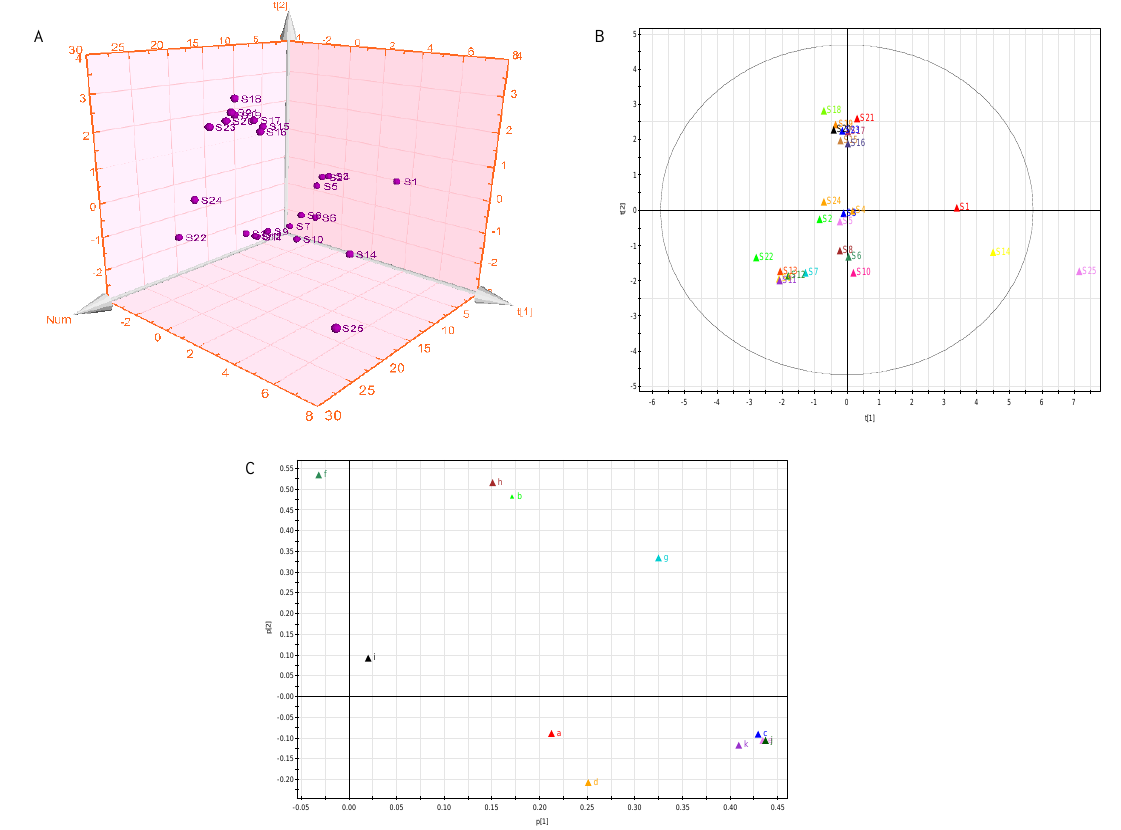
Figure 4. ( A ) The 3D scatter plot of scores of samples from the principle component analysis (PCA) model. ( B ) PCA score plot of 25 Moringa oleifera samples. ( C ) The loading scatter plot of the PCA model.